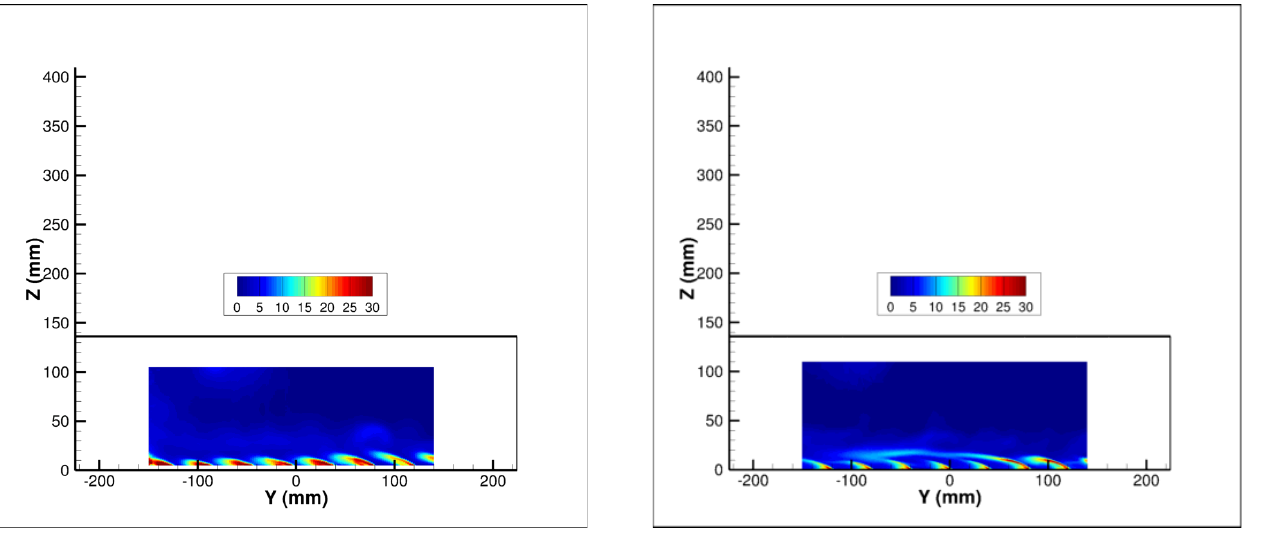
Figure 19. Turbulent kinetic energy map at 4th